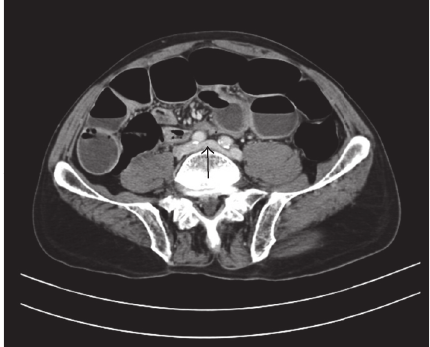
Figure 4: Left internal iliac vein draining to right common iliac vein (black arrow).